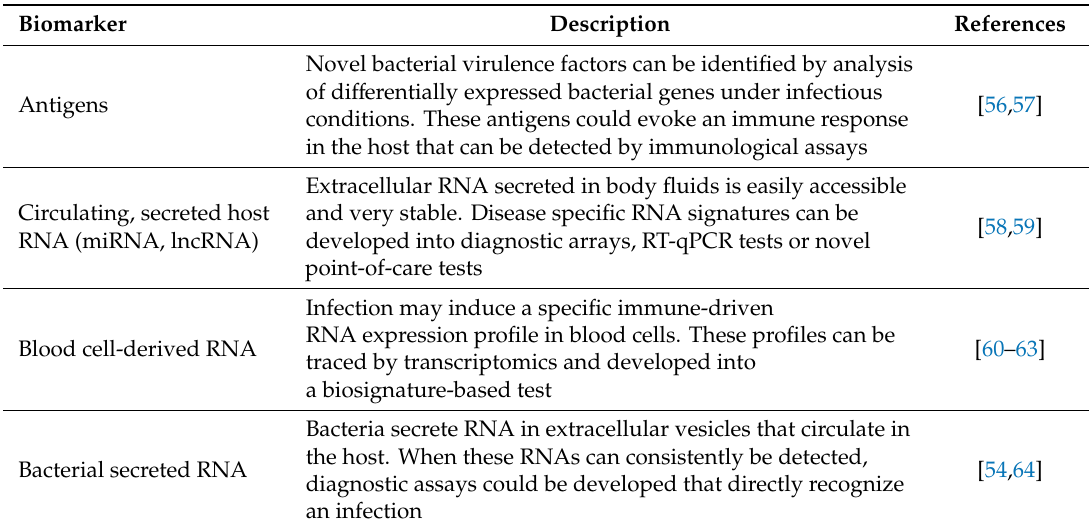
Table 1. Possible diagnostic biomarkers detected by